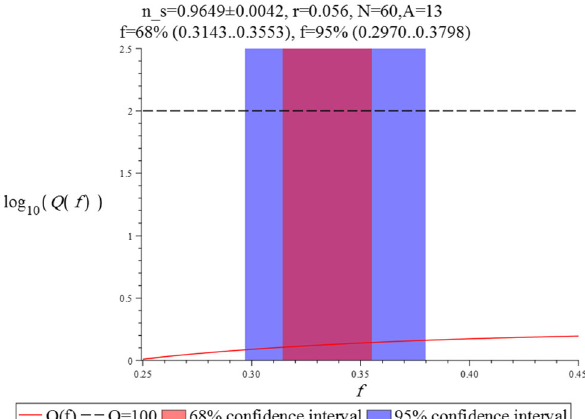
Fig. 1 In these two pictures, we compare the theoretical results of our model with Planck observational data